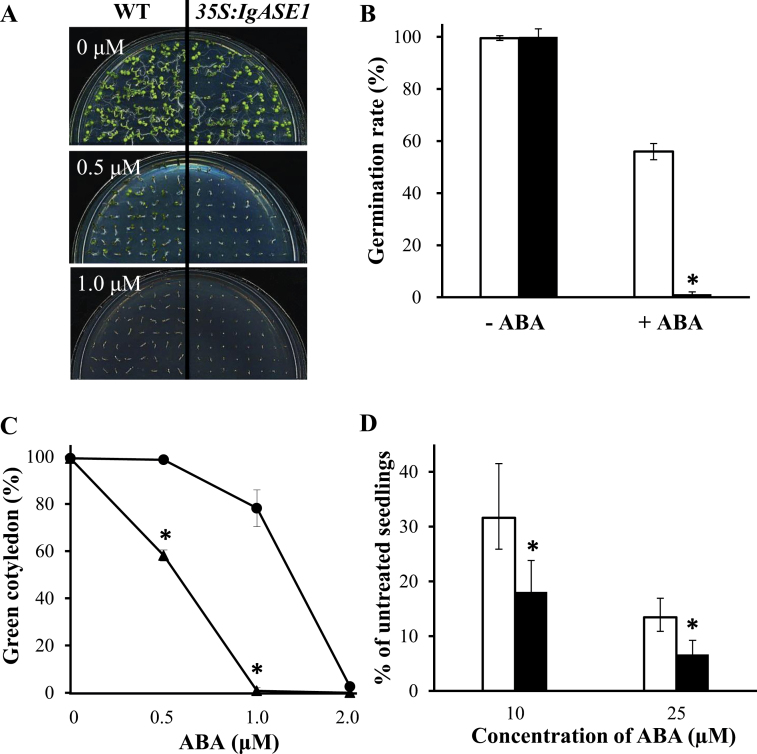
Effect of exogenous ABA on seed germination and early seedling development. (A) Effect of ABA on early seedling growth. Sterilized and stratified seeds were grown on ½ MS medium without or with 0.5 and 1 μM ABA for 8 days. (B) Percentage seed germination after 48h incubation of WT (white columns) and transgenic Arabidopsis (black columns) on ½ MS medium with or without 0.1 μM ABA. Values are means ± SE from three repeats; n = 56 for both WT and transgenic plants. (C) Percentage of seedlings that developed green cotyledons 12 days after sowing on media in the presence of different concentrations of ABA; WT, black circles; transgenic, black triangles. Values are the mean percentage ± SE (n = 52) from three repeats. *P < 0.05 in a Student’s t test. (D) Percentage fresh weight of the shoots of WT (white columns) and transgenic (black columns) plants relative to the untreated seedlings grown on ½ MS medium for 18 days without or with 10 and 25 μM ABA. Values are mean weight ± SE (n = 15) from three repeats. *P < 0.05 in a Student’s t test. This figure is available in colour at JXB online.